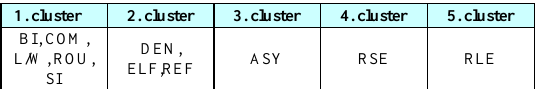
Table 2. Subjective division of the features of general shapes according to features in five